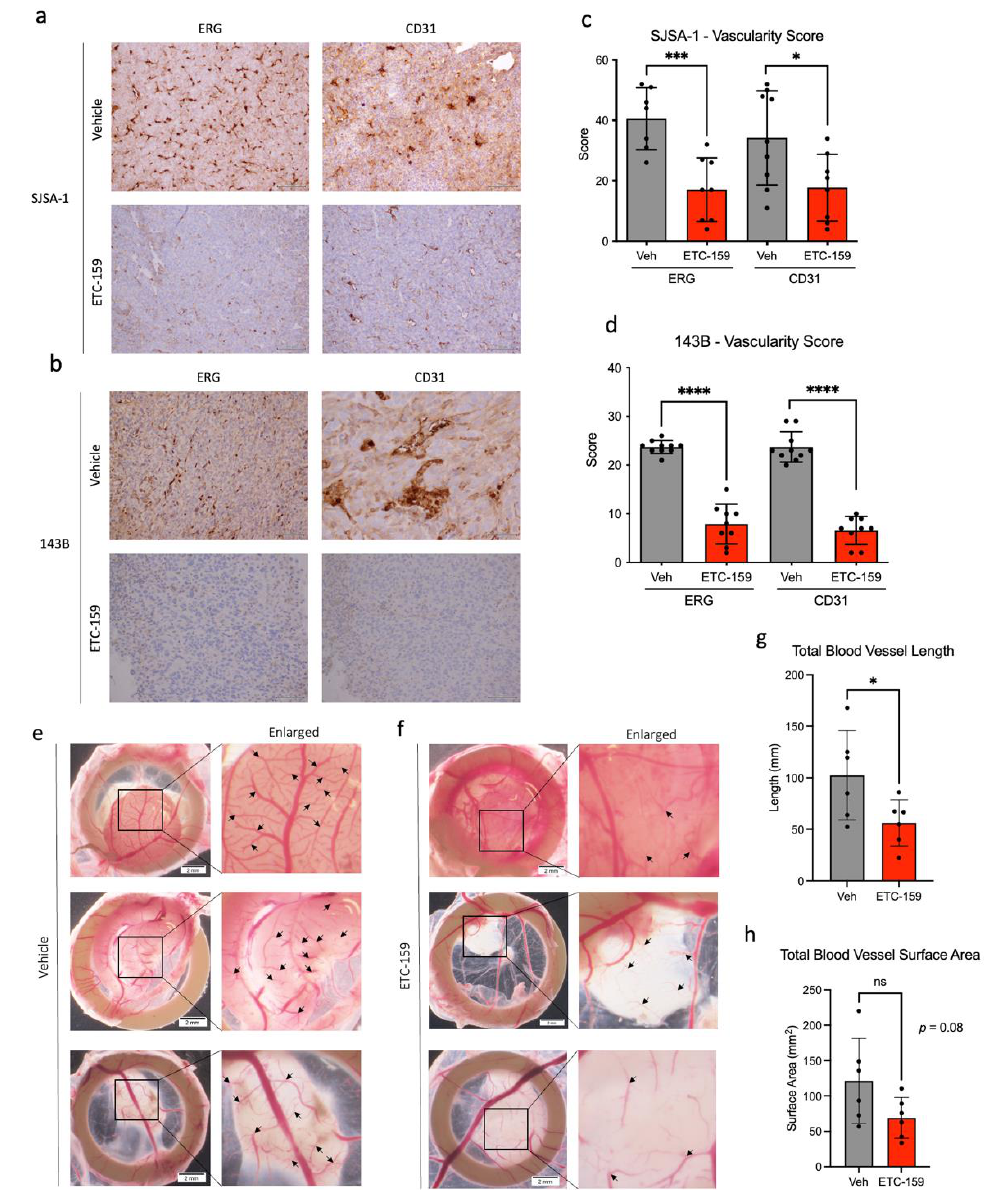
Figure 3. IHC of ERG and CD31 (endothelial markers) in ( a ) SJSA-1 and ( b ) 143B xenografts, showing a reduction after treatment with ETC-159. Images were captured at 200 × magnification. Quantification of vascularity score in ( c , d ) for SJSA-1 and 143B respectively. SJSA-1 cells grafted onto CAM and treated with ( e ) vehicle or ( f ) ETC-159 ( n = 6). Representative images of 3 independent tumours are shown, with insets magnified. Quantification of ( g ) total blood vessel length and ( h ) total blood vessel surface area. “ns” indicates not significant, * indicates p < 0.05, *** indicates p < 0.001, **** indicates p < 0.0001. Significance was calculated with unpaired two-tailed Student’s t